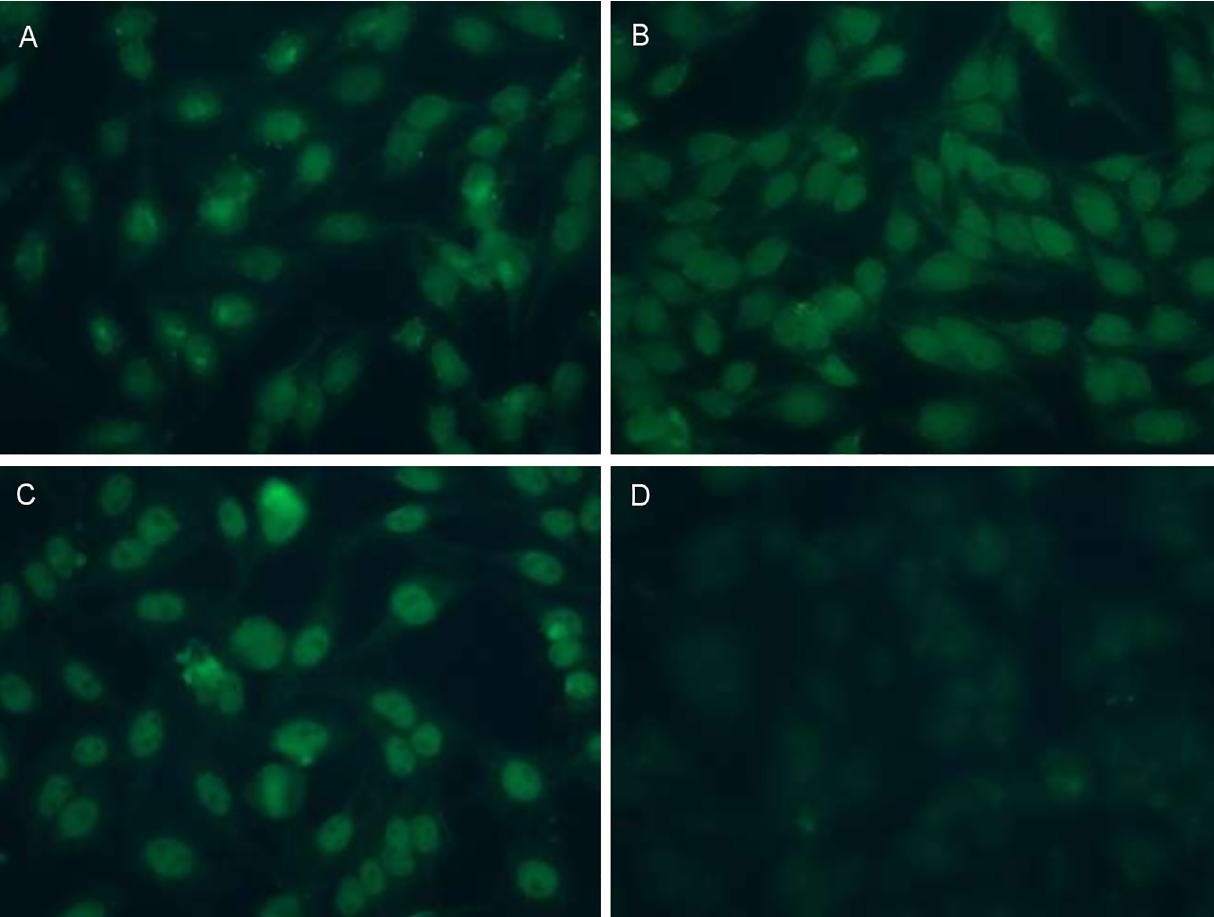
Fig 2. HEp-2 indirect Immunofluorescence (IFA) of IPF Plasma. A-C) Illustrate IFA patterns present among AE-IPF patients. All three AE-IPF patients whose plasma HEp-2 images are shown here (A-C) had negative assays for conventional clinical laboratory autoantibodies (see Online S1 Table in S1 File). Titrations here are 1:320 (A), 1:160 (B), and 1:80 (C). D) Negative IgG control.